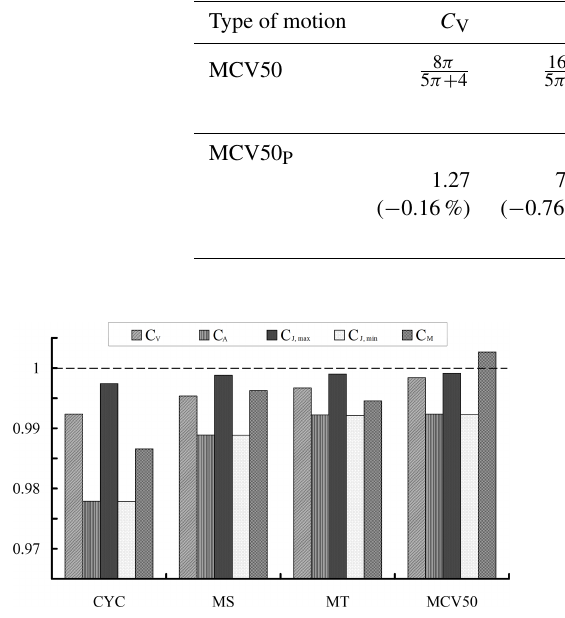
Figure 12. Ratio of motion characteristics of synthesized motions to trigonometric